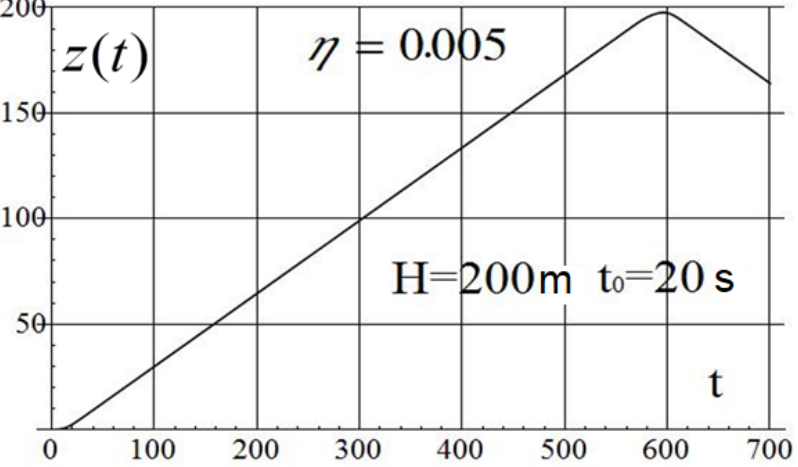
Figure 13. Submergence of the cylinder versus time for l c = 1 m, H = 200 m, η = 0.005, t 0 = 20 c .